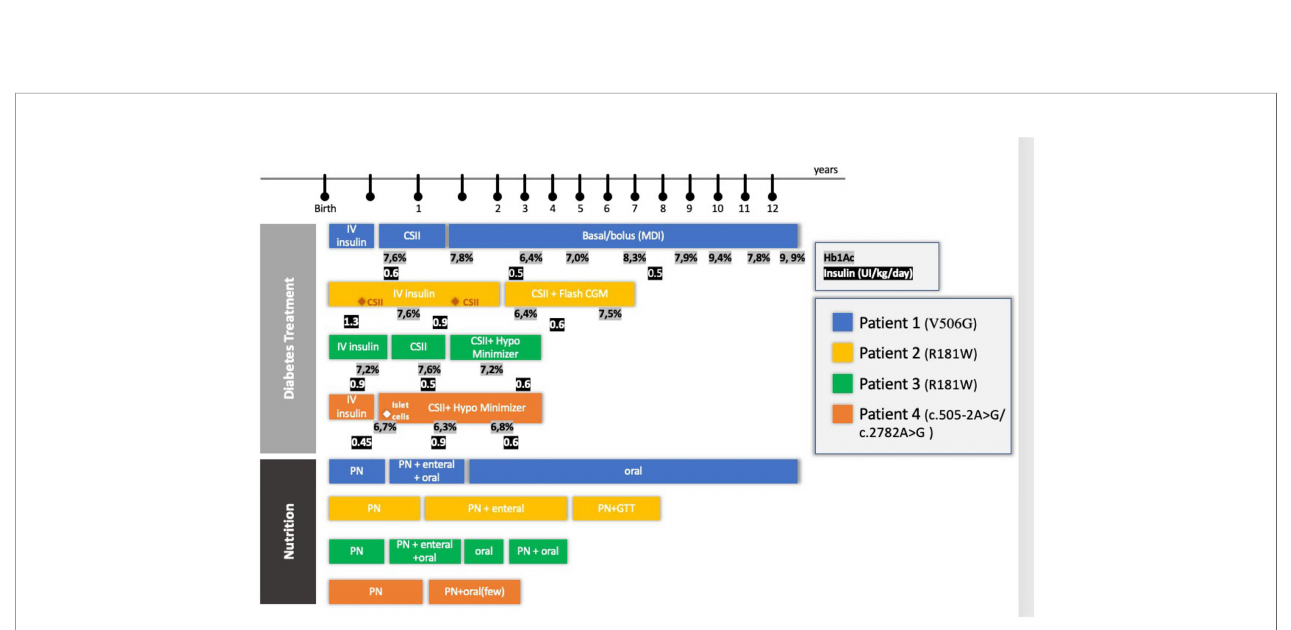
FIGURE 2 | Diabetes Treatment and Nutrition follow-up of four patients with RFX-6 mutation. PN, parenteral nutrition; CSII, Continuous Subcutaneous Infusion System; Hb1Ac, glycosylated hemoglobin; CGM, continuous monitoring system; GTT, gastrostomy; HypoMinimyzer, The Predictive Hypoglycemia Minimizer System.